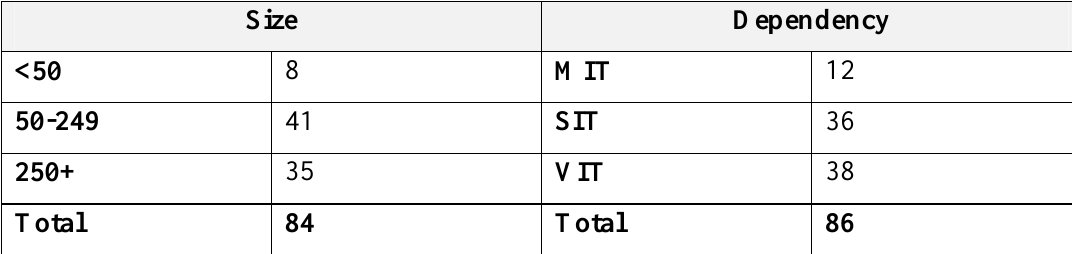
Table 5 – Numbers of Companies Responding the Role